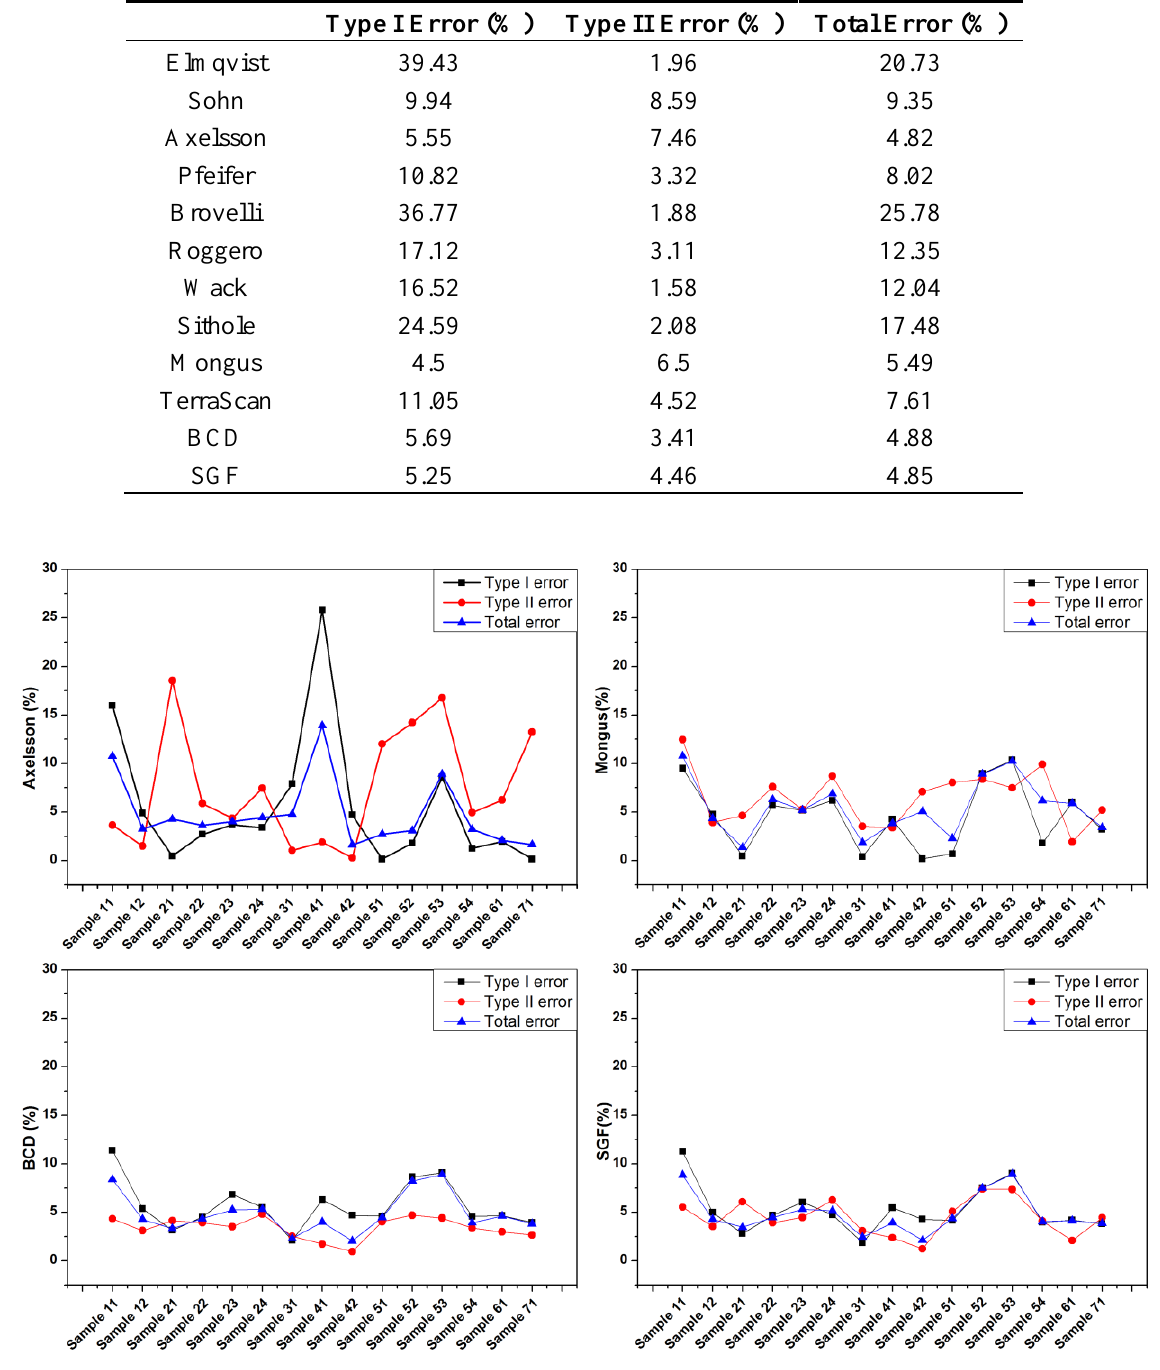
Table 1. Comparison of average accuracy among the eight classical filtering methods, parameter-free method (Mongus), TerraScan, BCD, and the proposed SGF algorithm for all benchmark study samples (the number in boldface indicates the smallest value in each error type, implying the corresponding method has the best performance).